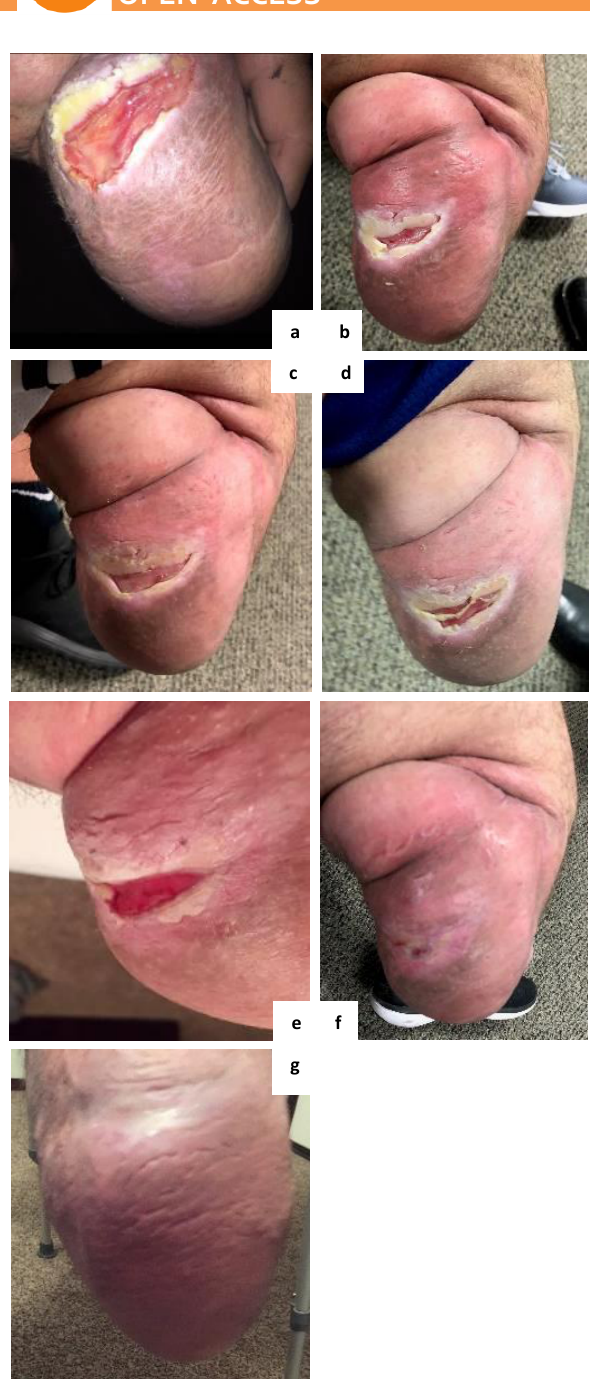
Figure 2: The condition of the Case #2 patient’s residual limb (a) approximately one year before being fitted with a perforated liner, (b) at the point of fitting, and after (c) 4 weeks of use, (d) 7 weeks of use (the point of changing to passive vacuum suspension), (e) 9 weeks of use, (f) 11 weeks of use and (g) 13 weeks of use.